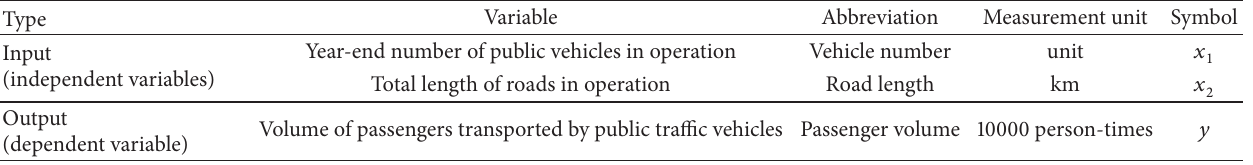
Table 1: The input variables and output variable for quantitative analysis of the public transportation of China’s cities (2006–2012).